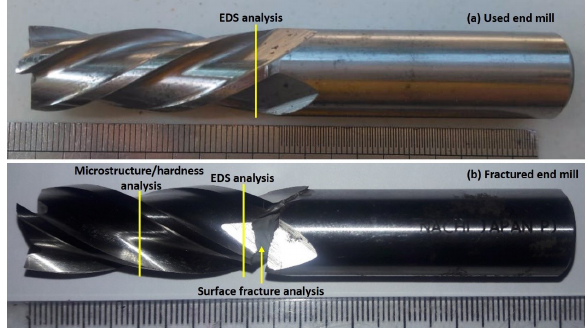
Figure 1: The points of investigation in (a) used end mill, (b) frac- tured end